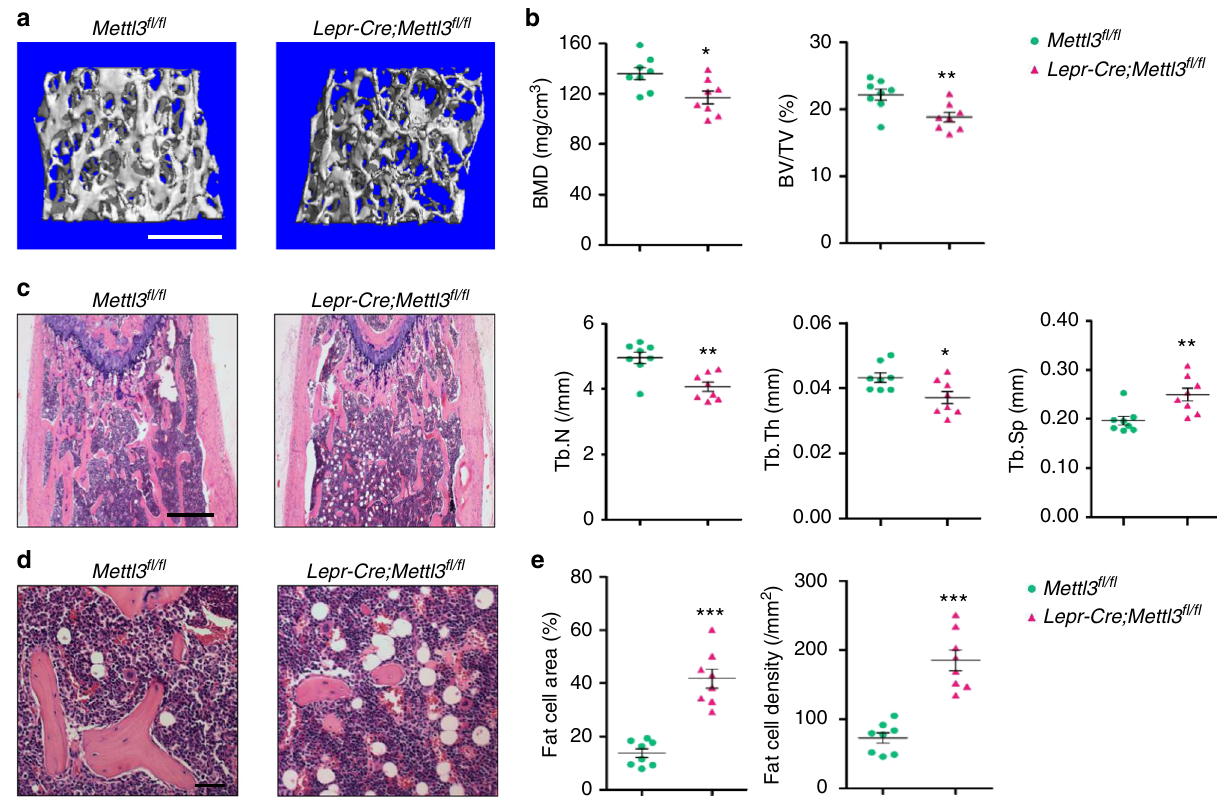
Fig. 3 Deletion of Mettl3 in Lepr + MSCs results in bone impairment and marrow fat accumulation. a Representative μ CT images of distal femurs of 4- month-old male mice. Scale bar, 500 μ m. b Quantitative μ CT analyses of distal end of femurs ( n = 8). c H&E staining of femoral sections from Mettl3 fl / fl and Lepr-Cre;Mettl3 fl / fl male mice. Scale bar, 500 μ m. d Representative H&E staining of femur sections exhibiting the marrow adipose tissue. Scale bar, 50 μ m. e Number and area of adipocytes in the distal marrow per tissue area ( n = 8). Data are expressed as mean ± s.e.m.; * P < 0.05, ** P < 0.01, *** P < 0.001 by two-tailed Student ’ s t